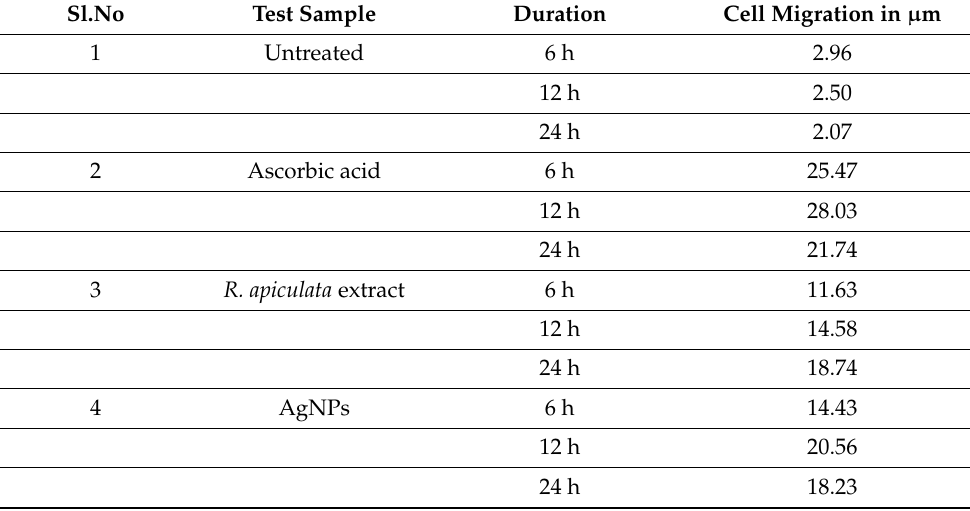
Table 9. Cell migration of different test samples at different duration.